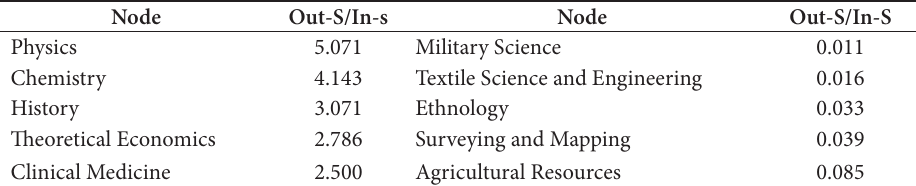
Table 5. Ratio of knowledge inflow and outflow of some nodes (2)